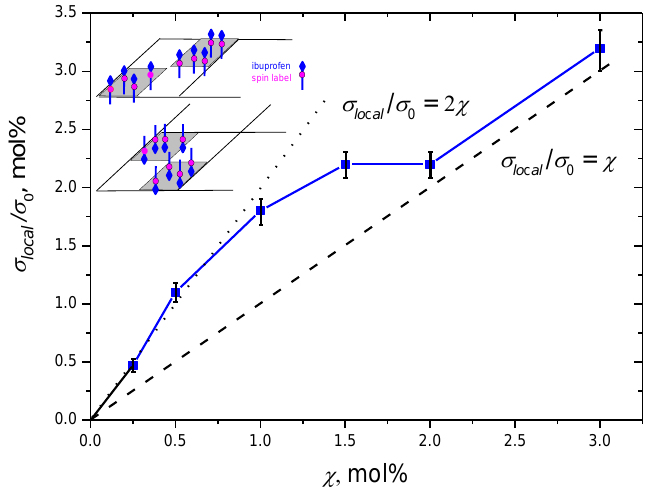
Figure 4. Local ibuprofen-SL surface concentration σ local in the POPC bilayer as a function of molar concentration χ . The data are presented in dimensionless units, σ local / σ 0 , where σ 0 represents the lipid surface concentration (assessed as 1.7 nm − 2 , see text). The dashed and dotted lines present the functions σ local / σ 0 = χ and σ local / σ 0 = 2 χ , respectively. The inset schematically shows a possible distribution pattern of ibuprofen between two leaflets of the bilayer (a chess box model).